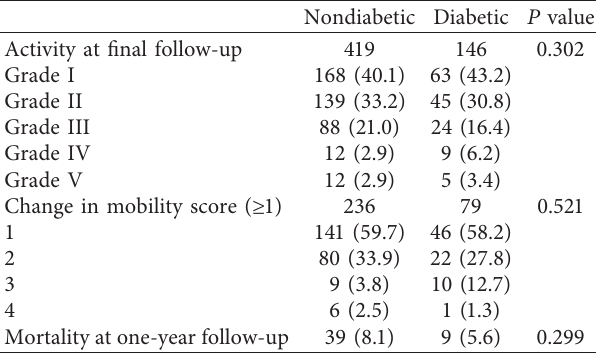
Table 3: Comparison of 1-year outcome and mortality after fracture in the two groups of